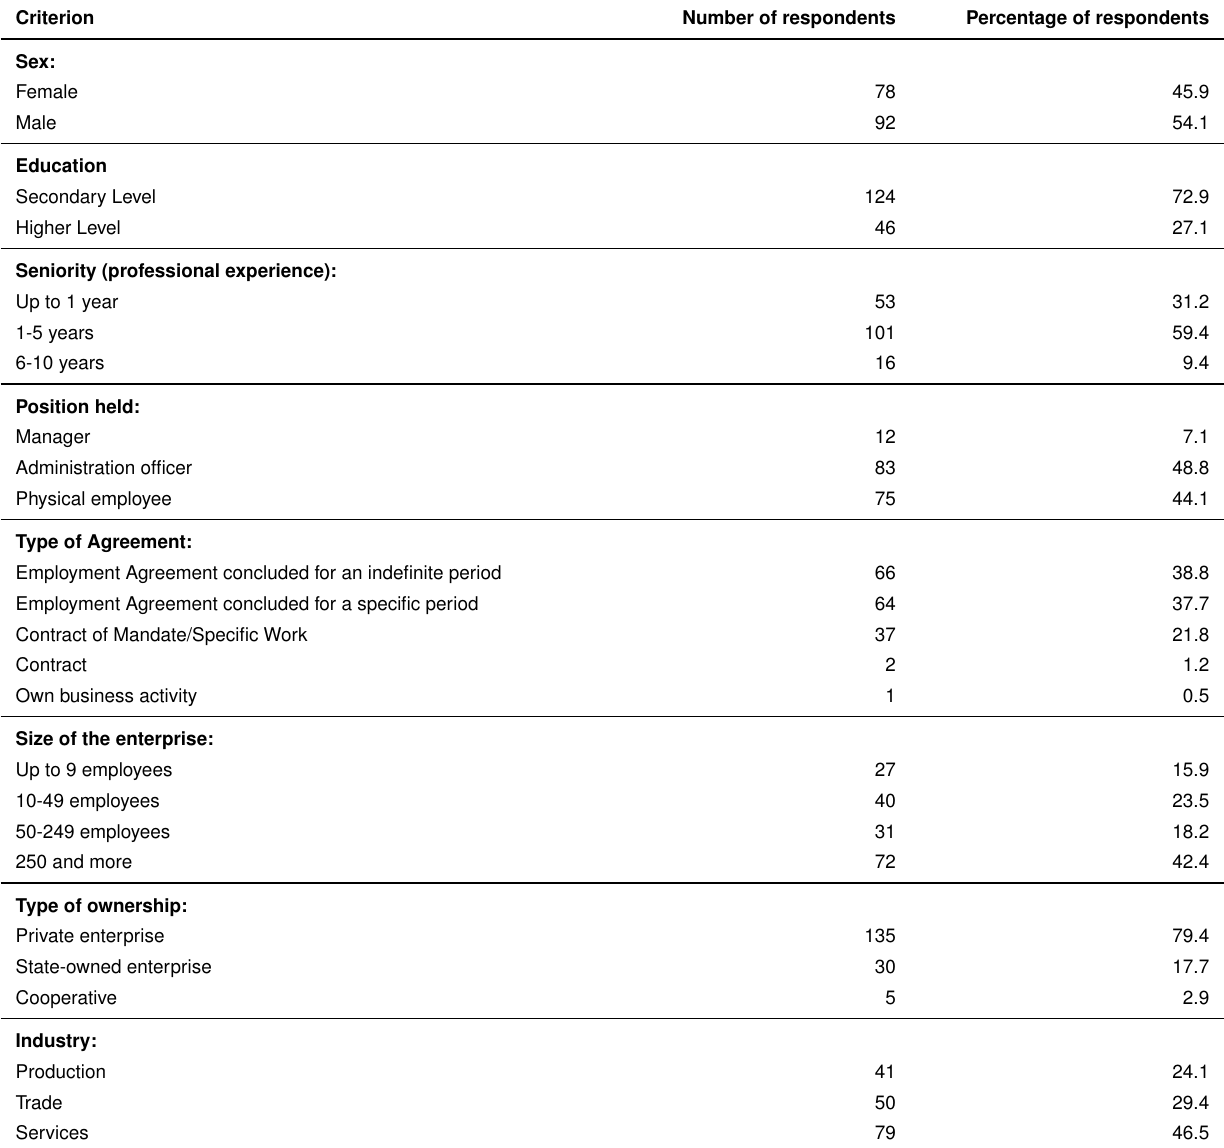
Table 1. Study Respondent Profile (N =